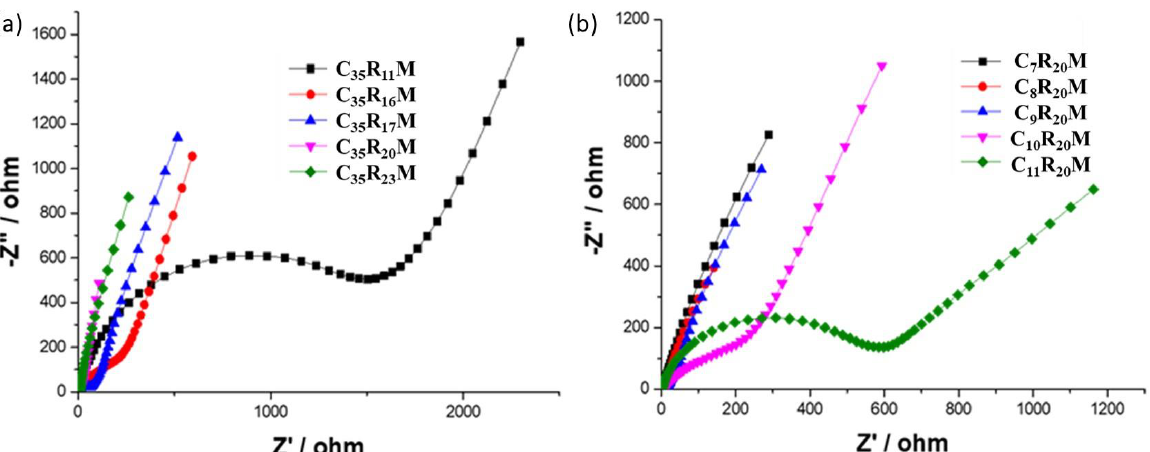
Figure 5. Nyquist plot of the ( a ) C 35 R y M and ( b ) C x R 20 M electrodes with various contents of Ru and Cu, respectively (( a ) Ru and ( b ) Cu).